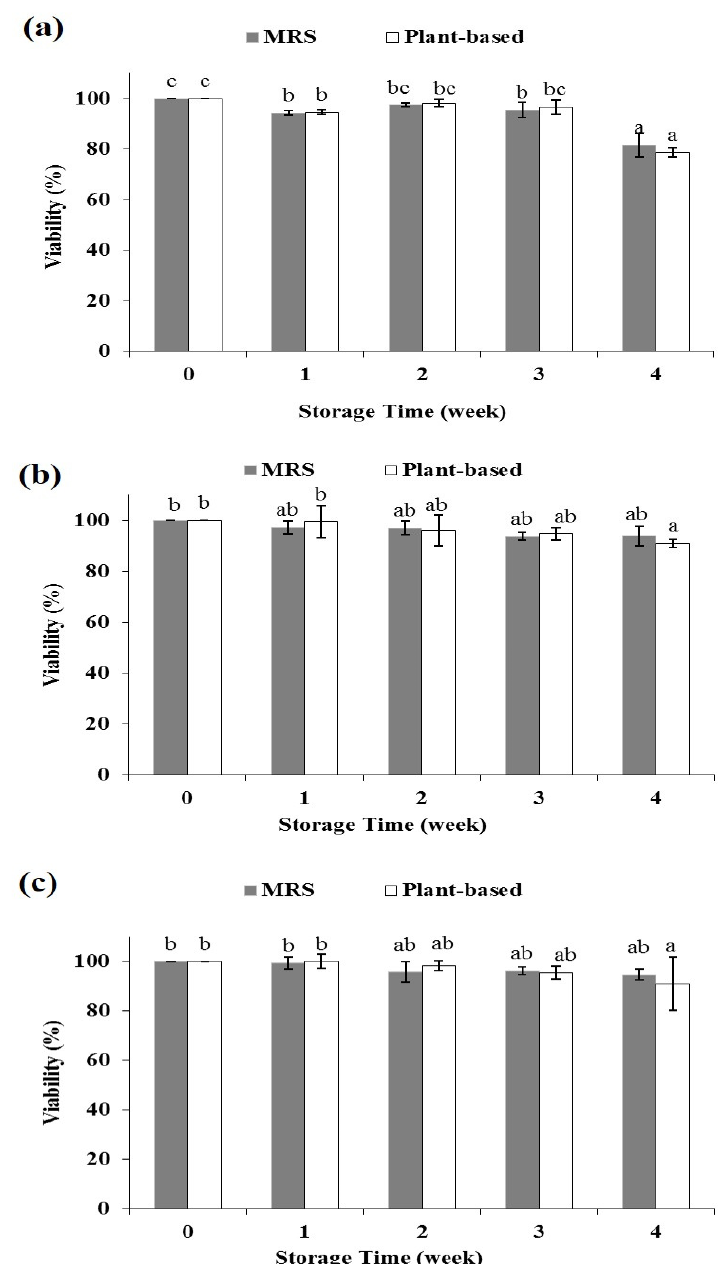
Figure 3. Viability of Lpb. plantarum TISTR 2075 ( a ); Lpb. plantarum MW3 ( b ); Lcb. casei TISTR 1463 ( c ) after cold storage for one month in different media (slant agar stock culture). Each color is the average of three replicates. Different superscripts indicate significant difference ( p < 0.05) .